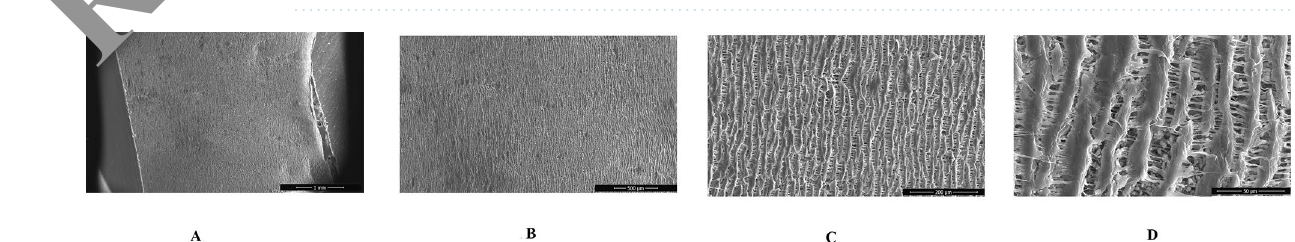
Figure 7. The relationship between clot removal rate and magnet rotating frequency (error bars indicate standard deviation p < 0.05)).